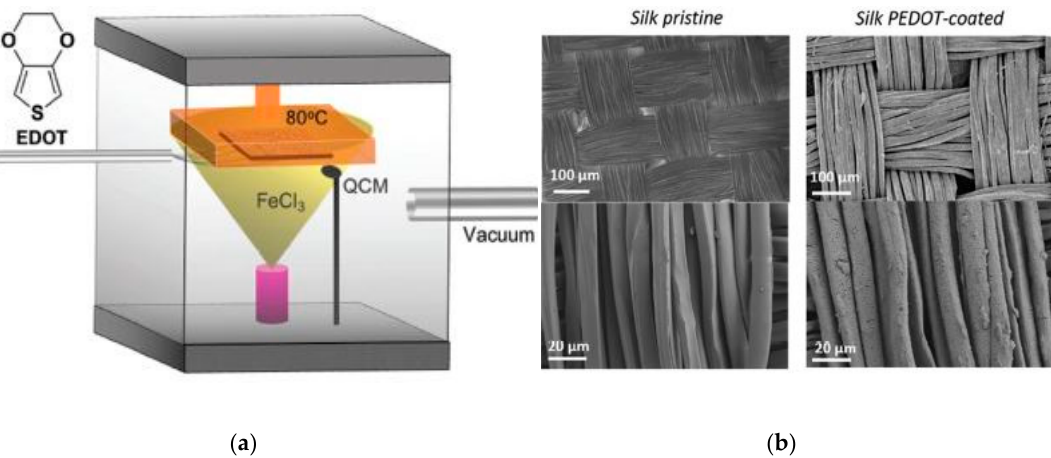
Figure 4. ( a ) The schematic illustration of vapor deposition system for PEDOT; ( b ) SEM images